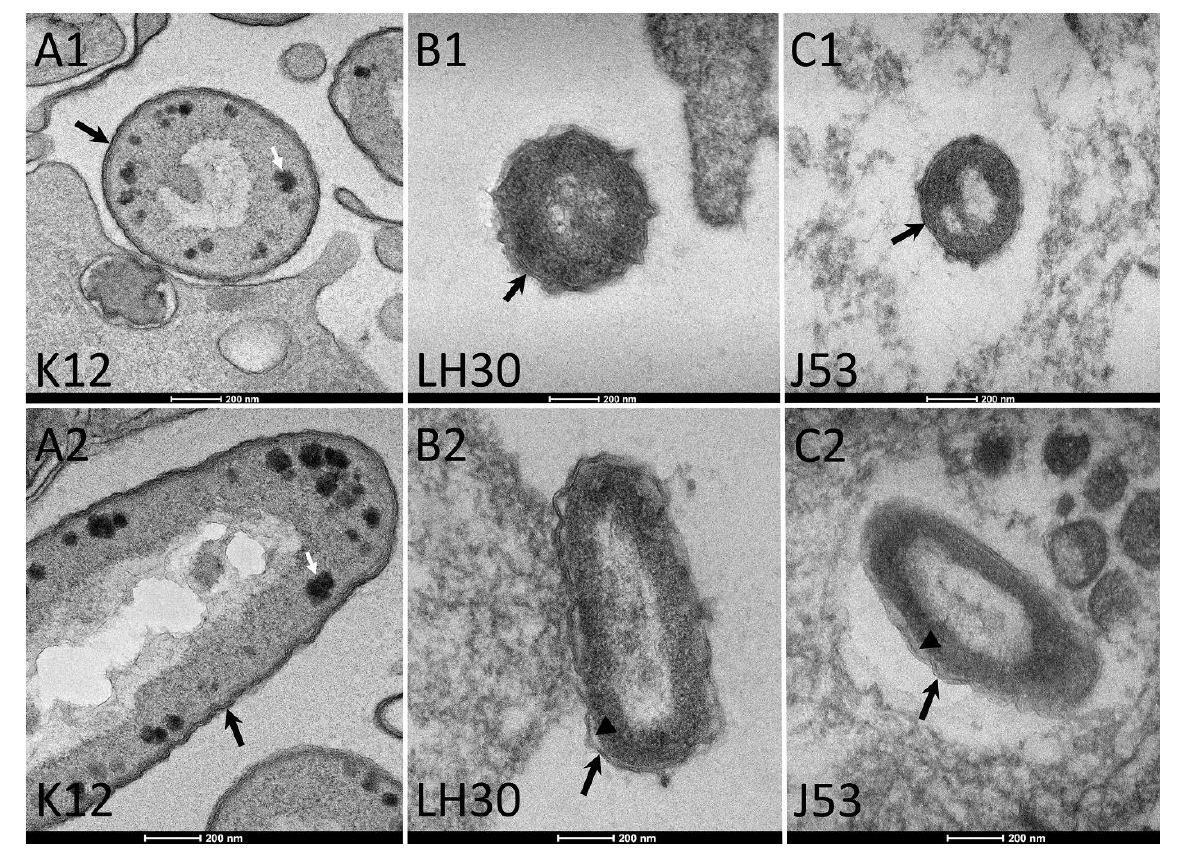
Figure 4. BSE-SEM observation of ultrathin sections of bacteria within the platelet aggregates. ( A1,A2 ): K12 E. coli transversal and longitudinal sections, respectively. ( B1,B2 ): LH30 E. coli transversal and longitudinal sections, respectively. ( C1,C2 ): J53 E. coli transversal and longitudinal sections, respectively. Black arrows: cell wall; white arrows: electron dense bodies; arrowheads: free space between cell wall and periplasm.